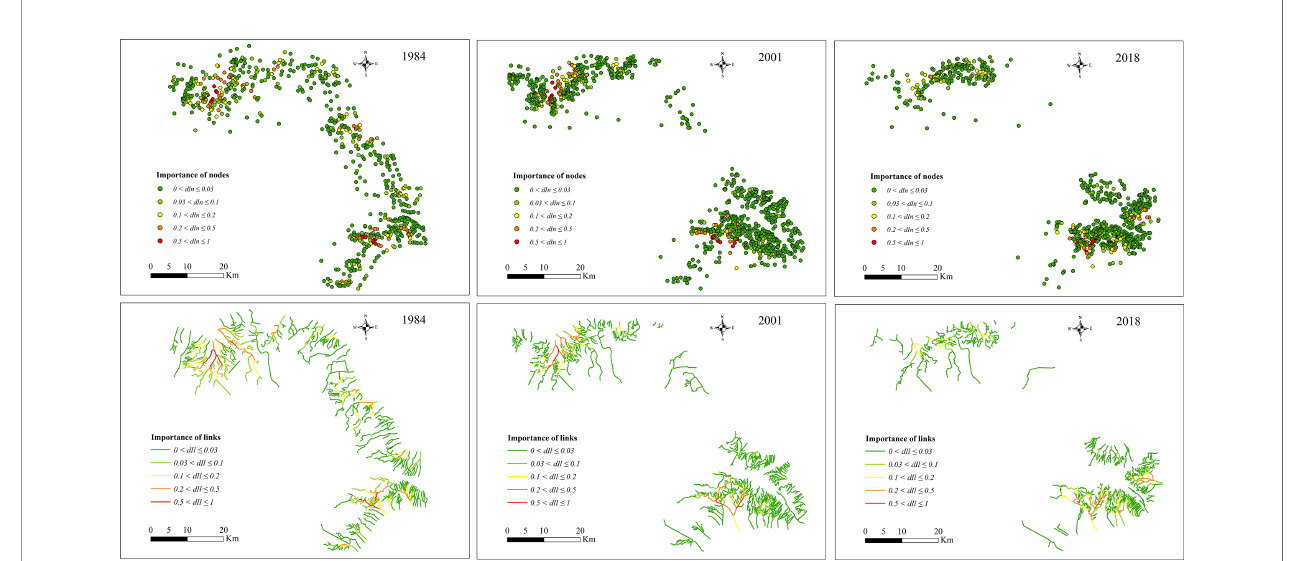
FIGURE 6 | Spatial arrangement of importance of nodes and links in 1984, 2001 and 2018 in the YRD.